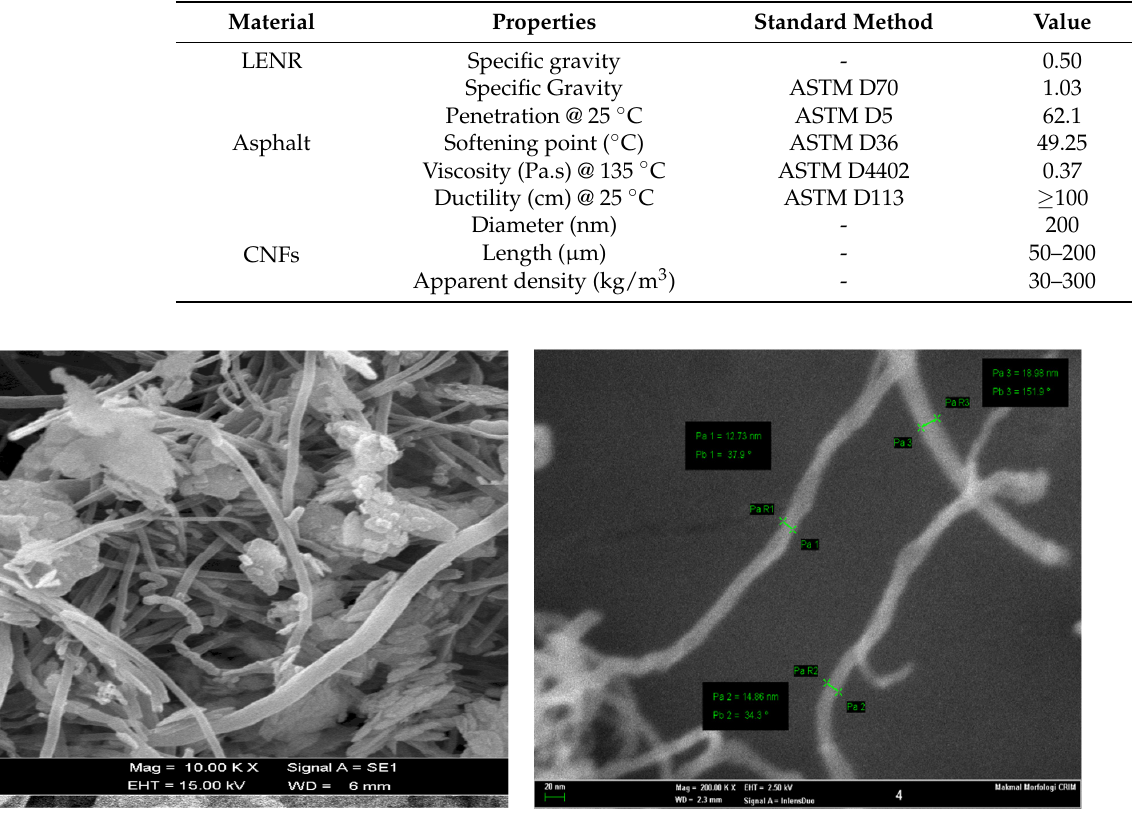
Figure 1. Transmission electron microscopy (TEM) images of